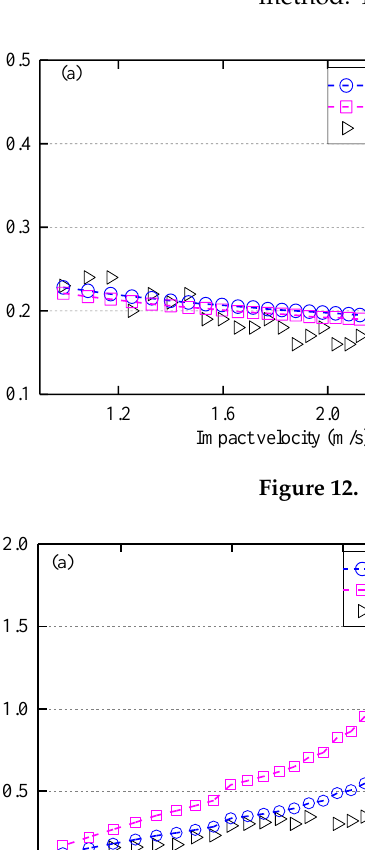
Figure 12. Comparison of impact duration: ( a ) Hertz model; ( b ) ML model.